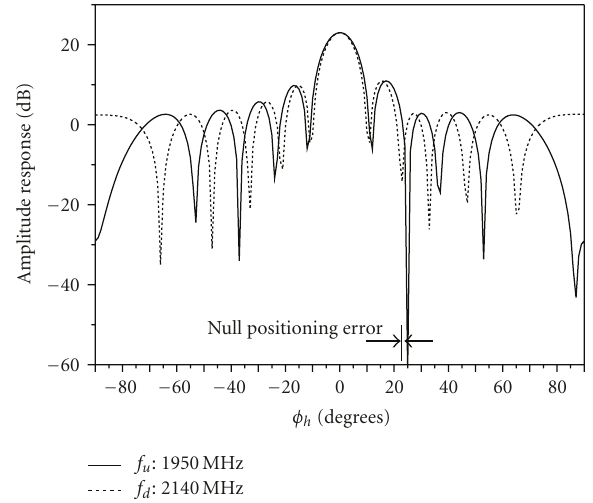
Figure 11: Comparison of the beam patterns of the receiver and transmitter using IMT-2000 frequency